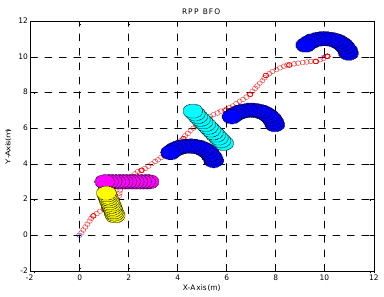
Fig. 14. 2nd scenario pathfor case3.